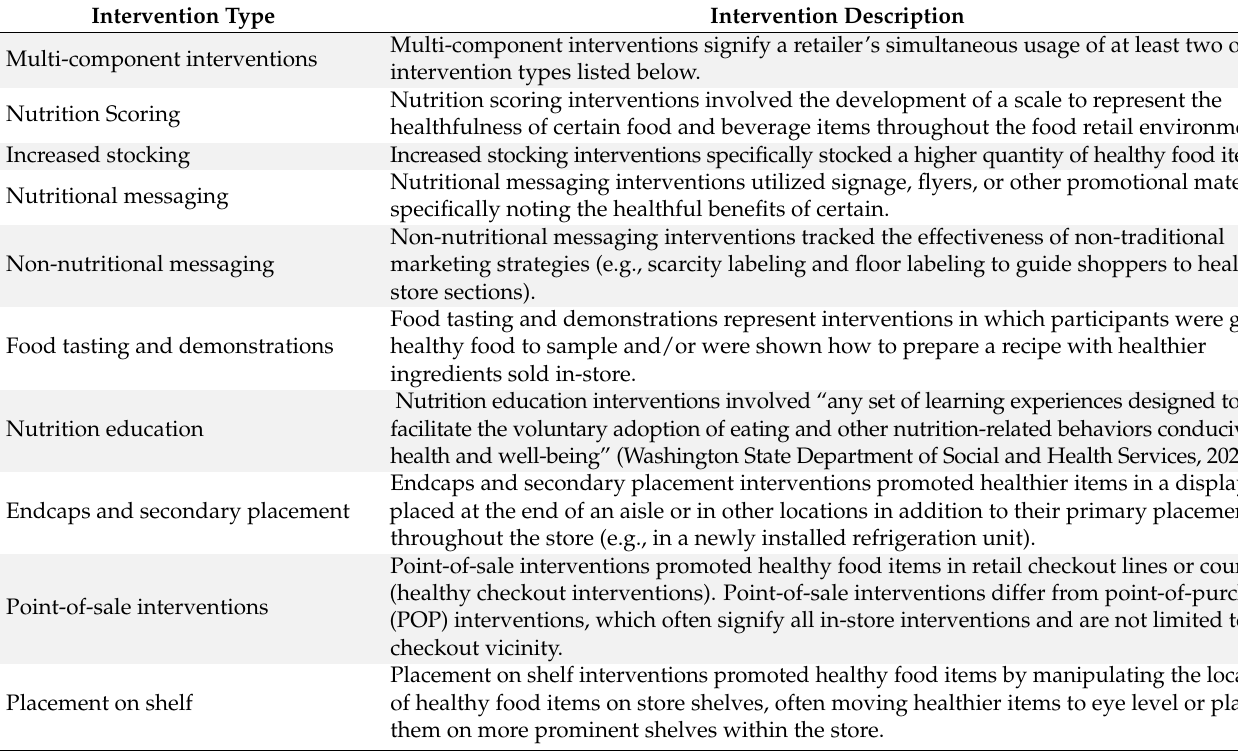
Table 1. Description of Intervention Types Included in